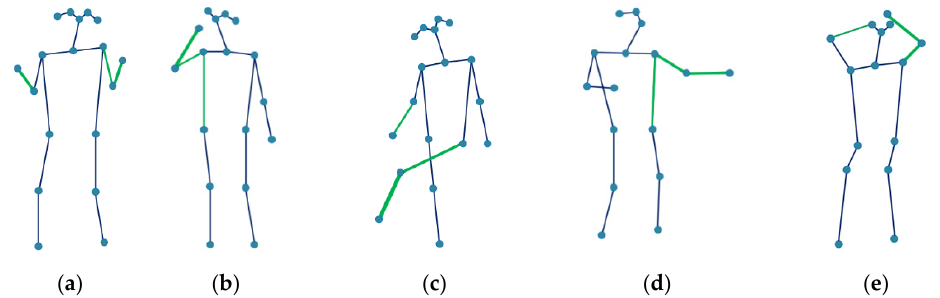
Figure 7. Visualization of the most informative joints with ST-GCN. ( a ) clapping; ( b ) talking on the phone; ( c ) kicking; ( d ) beating; ( e ) comb hair.